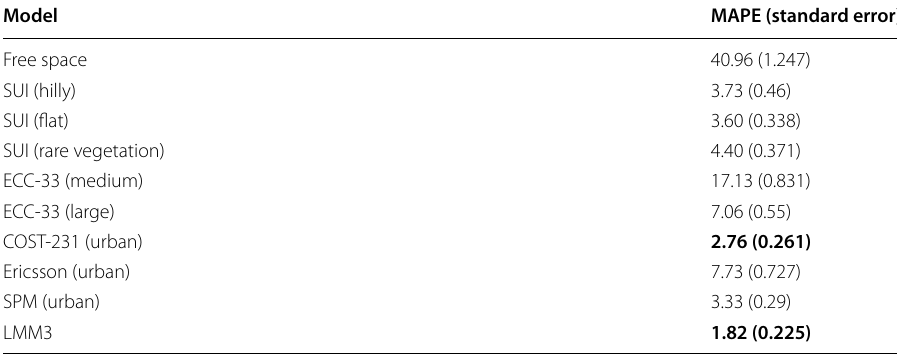
Bold values indicate the best models (Lower MAPE)